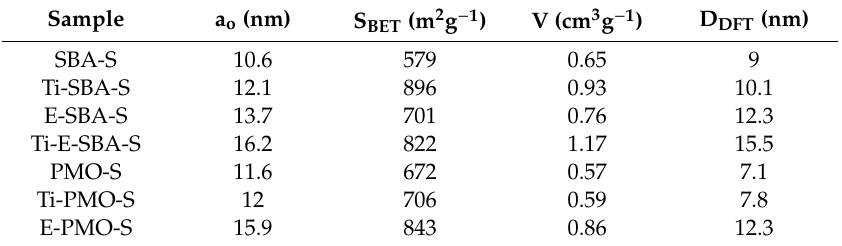
Table 1. Structural parameters of SBA-15 and periodic mesoporous organosilicas (PMO) samples.